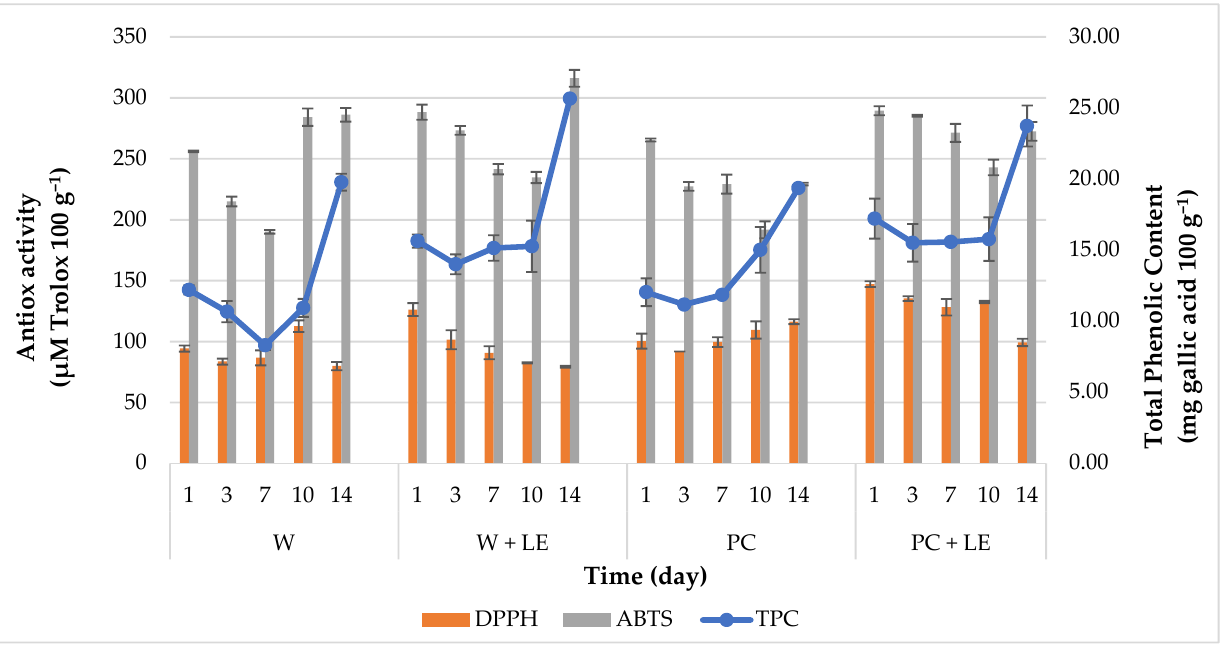
Figure 7. Total phenolic content (TPC) and expression of antioxidant activity (ABTS and DPPH assays) of uncoated and coated fresh-cut carrots throughout 14 days of storage (4 °C). Abbreviations: W; W + LE; PC; PC + LE (see Table 1).